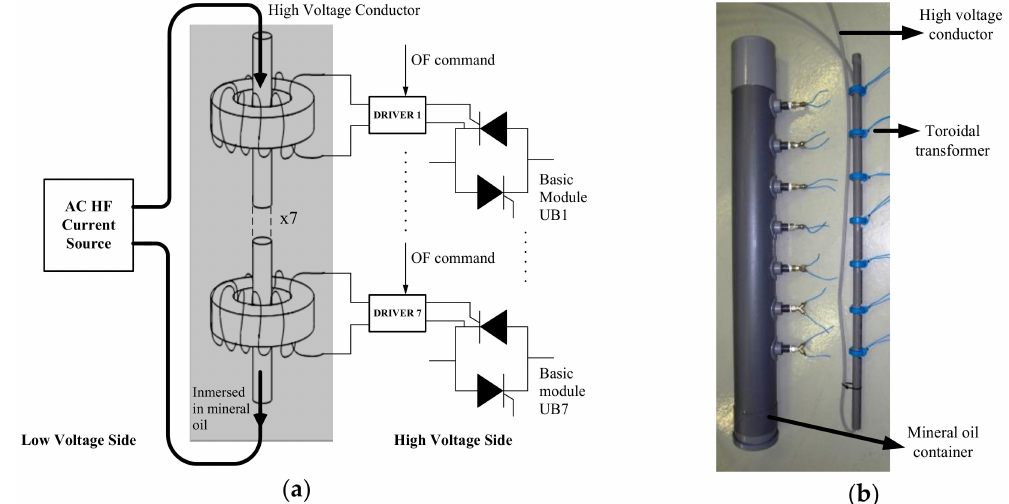
Figure 5. ( a ) AC current transformer topology with high-voltage isolation to feed thyristor drivers; ( b ) toroidal transformer assembly with high-voltage conductor. The assembly is included in the mineral oil